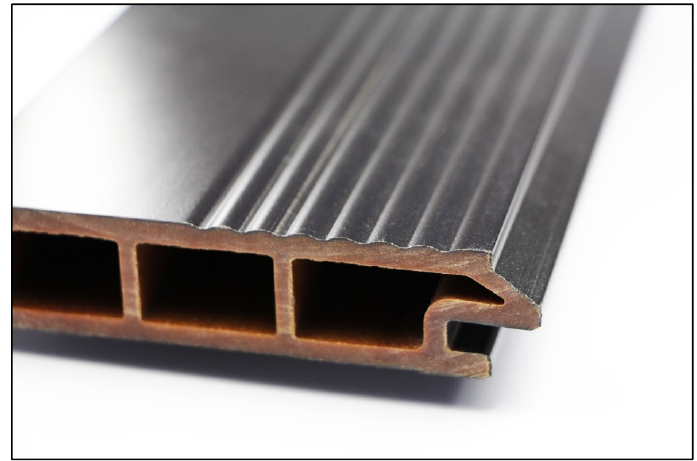
Figure 24. Profile geometry of the siding profile for extrusion.